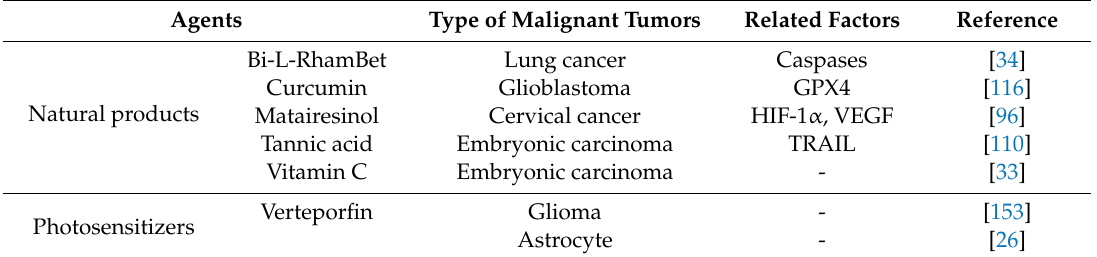
Table 2. Natural products and photosensitizers that a ff ect mROS